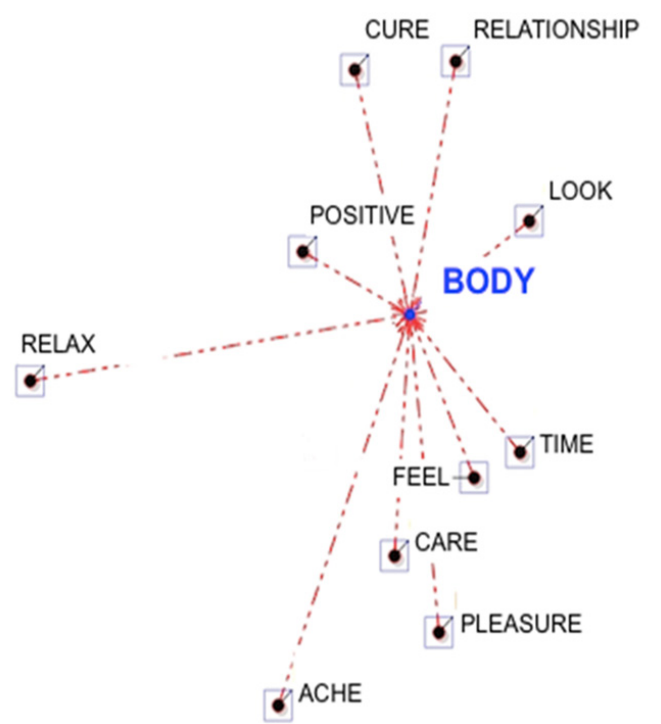
Figure 1. Graphical representation of the Word Association Analysis (before the psychological intervention).